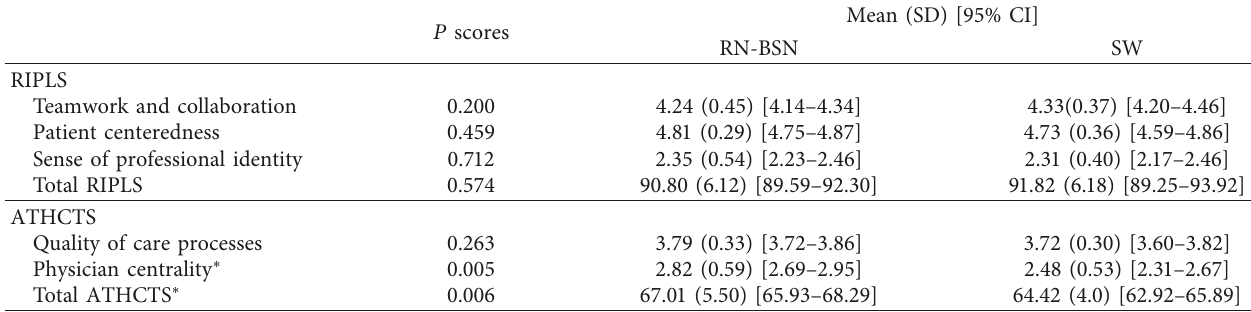
Table 2: RIPLS and ATHCTS scores by